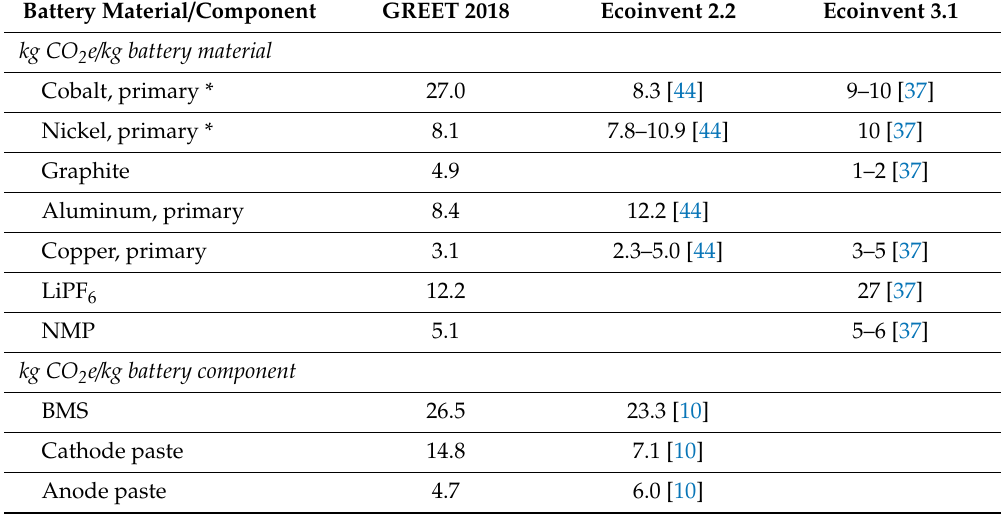
Table 3. Greenhouse Gases, Regulated Emissions, and Energy Use in Transportation (GREET) model vs. ecoinvent greenhouse gas (GHG) emission intensities for select battery materials and